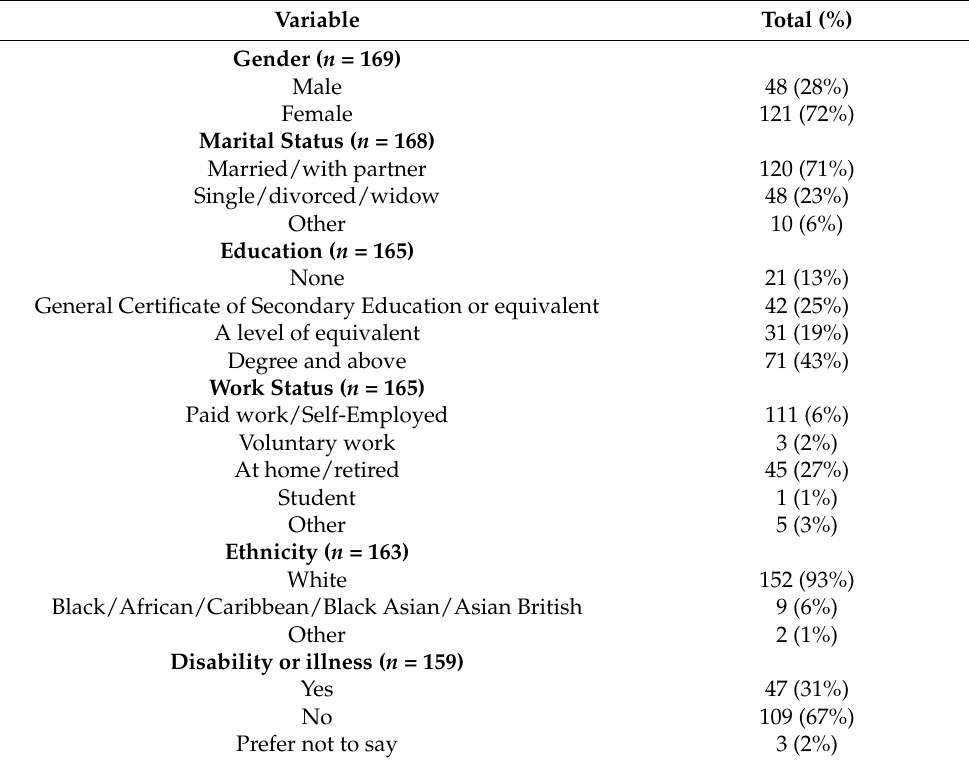
Table 2. Summary of the of evaluation participants’ demographic profile at